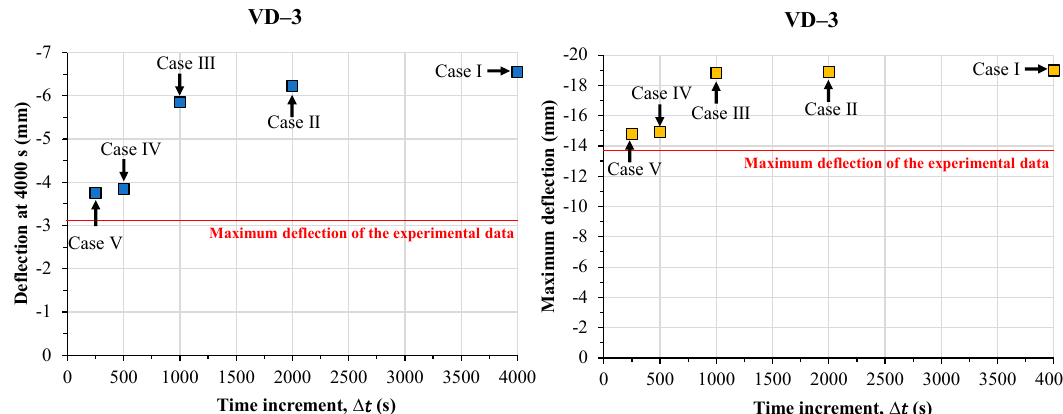
Figure 25. Deflection at 4000 s and maximum deflection versus time increments ( ∆ t ) at VD-3. Figures 26–28 analyze the reliability of two-FSI for deflection versus time increments ( ∆ t ) comparing to experimental data. In Figures 26–28, the mean of Case IV and Case V are 1.0272 and 1.0135 at VD-1; 1.0272 and 1.0209 at VD-2; 1.0337 and 1.0199 at VD-3 respectively. Thus, Cases IV and V have good agreement in all of the vertical displacement periods. Additionally, Case IV and Case V have lower COV than other cases as shown in tables in Figures 26–28. Figure 29 shows the deformed shapes of the H-beam under a propane burner fire at 4000 s generated by the non-linear structural analysis with different values of ∆ t .